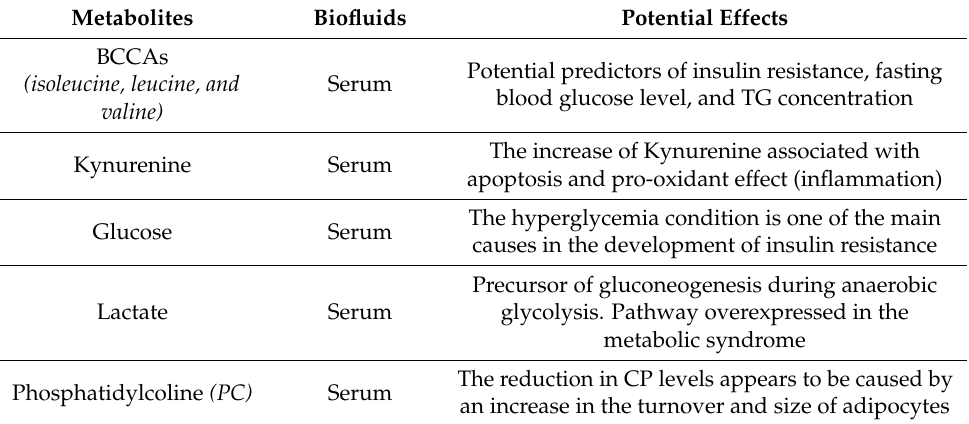
Table 3. Brief tabular summary of principal metabolites and their potential